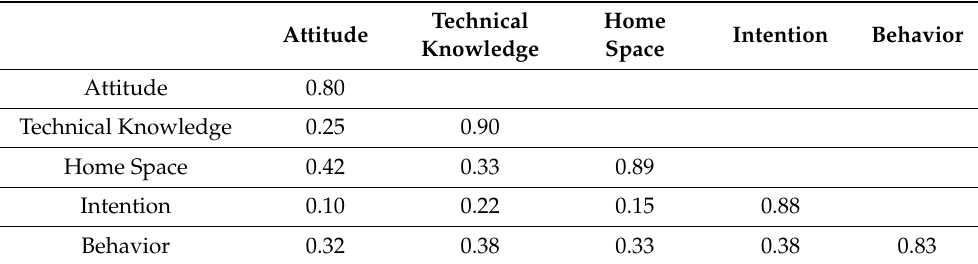
Table 4. Discriminant validity assessment through Fornell–Larcker